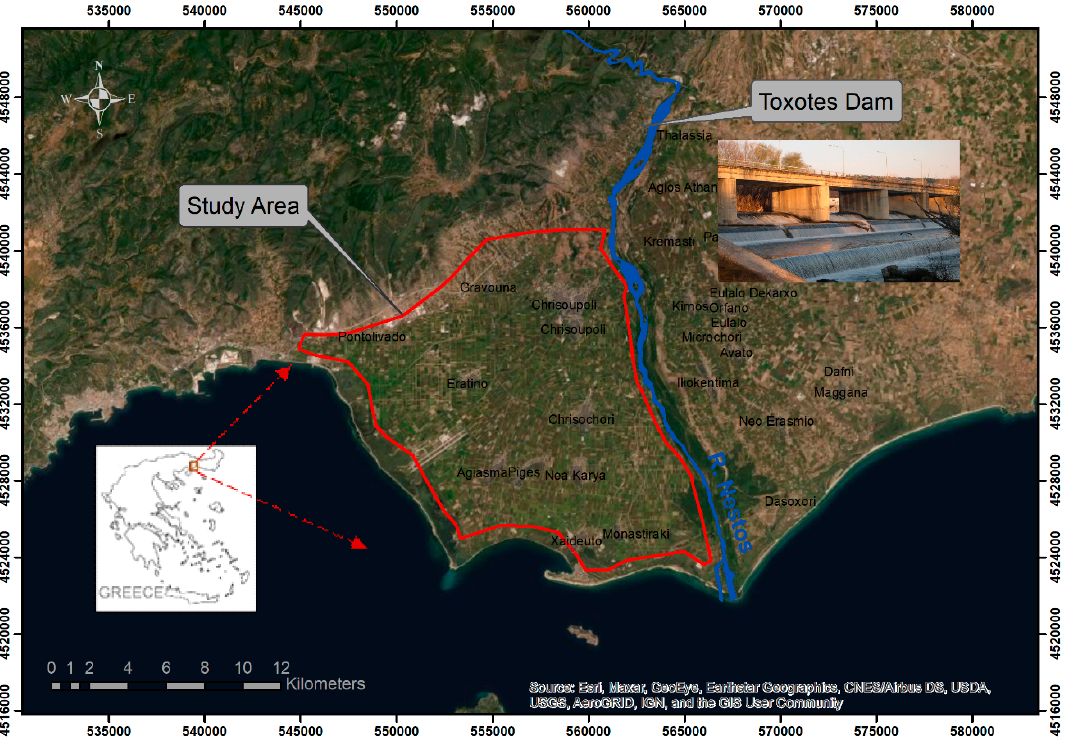
Figure 1. Study area (basemap source: Google, 2022).